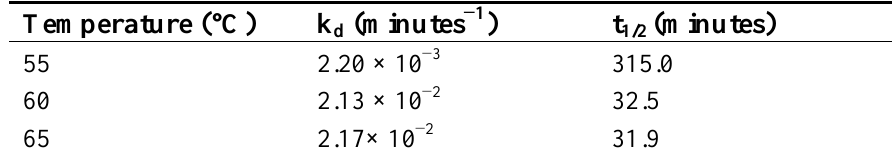
Table 2. Deactivation constant (k and 65 °C at pH 5.5.